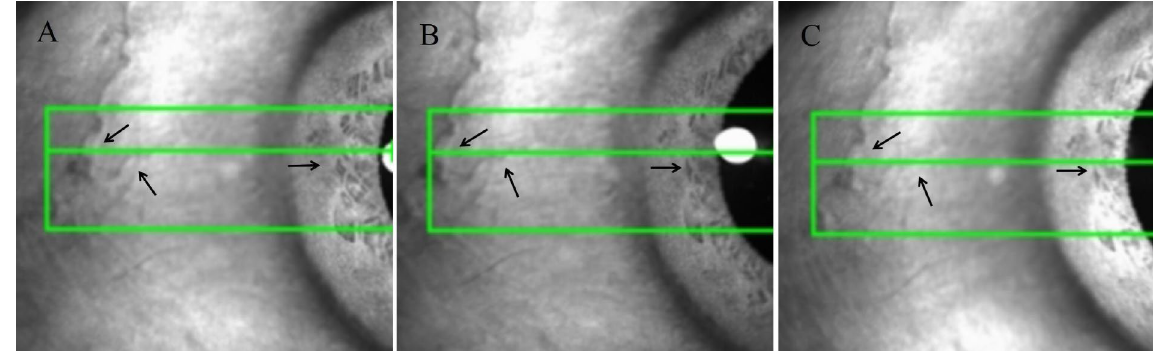
Figure 2. Conjunctival vessels and iris features (black arrow line) were used as landmarks to scan the same cross-section under different states. ( A ) base state. ( B ) -4D accommodation stimuli state. C: -8D accommodation stimuli